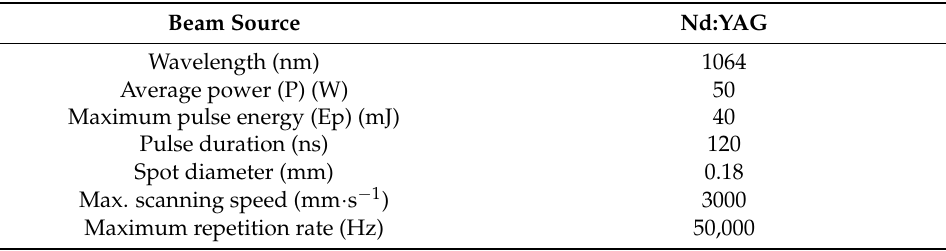
Table 3. Parameters of the laser